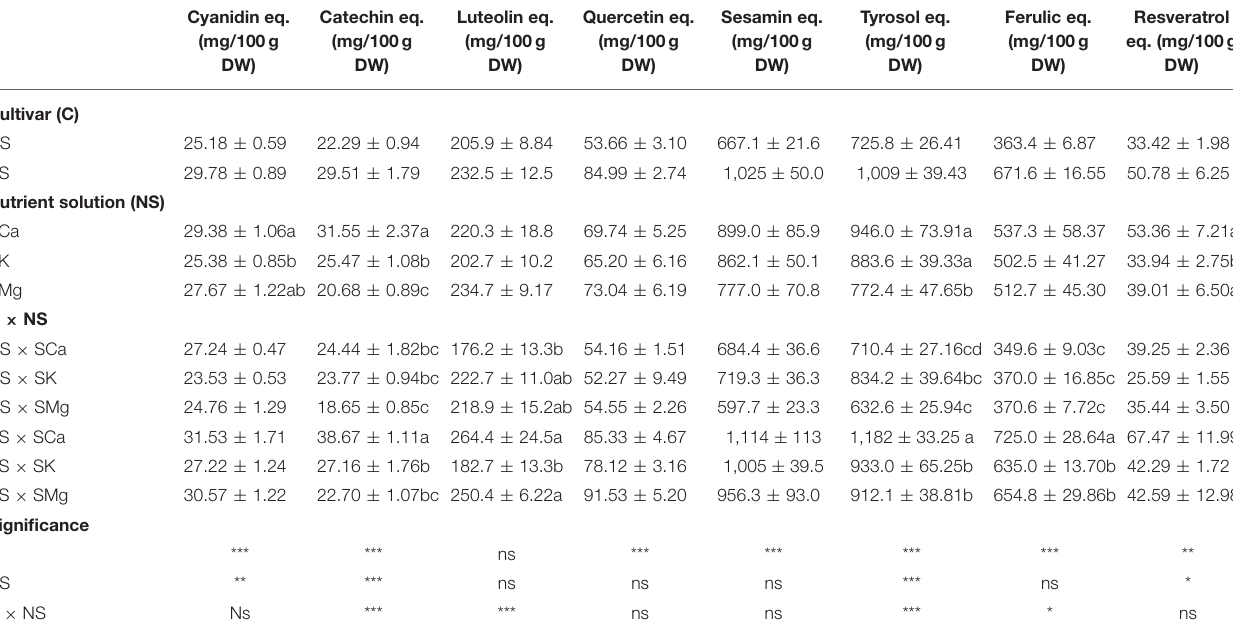
TABLE 5 | Effects of the C and of the NS on the untargeted phenolic profile of phenolic compounds of the